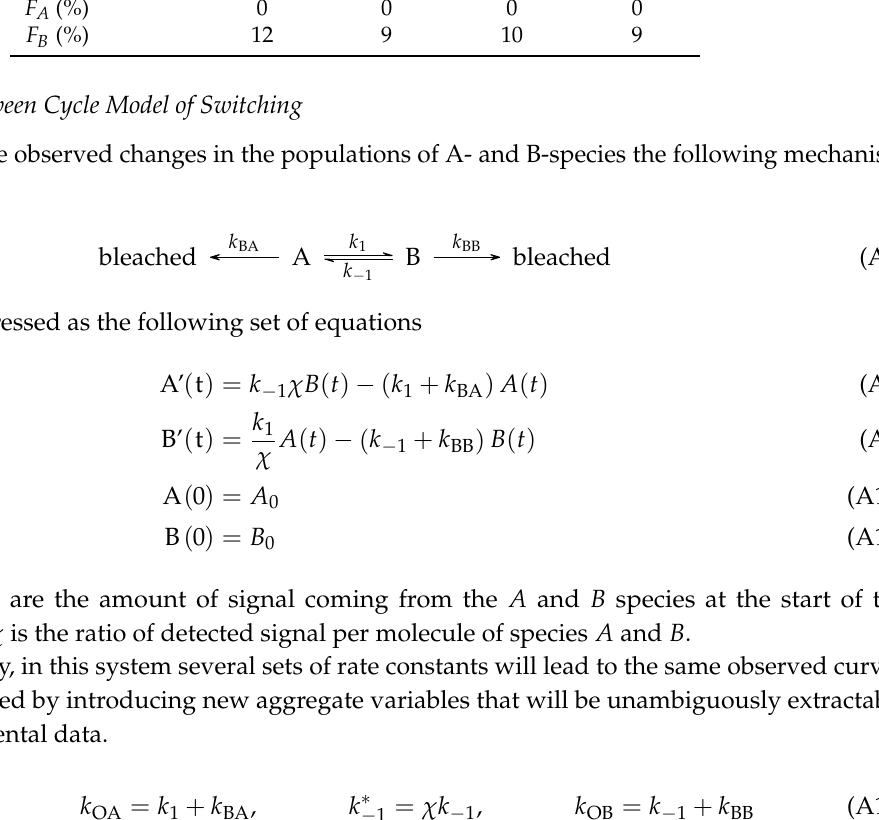
Table A2. Off-switching rate constants ( τ ) and residual fluorescence ( F ) of the two species. Photoswitching rsGreen1 rsGreenF rsGreen1 rsGreenF Parameter Enhancer Enhancer τ A (frames)